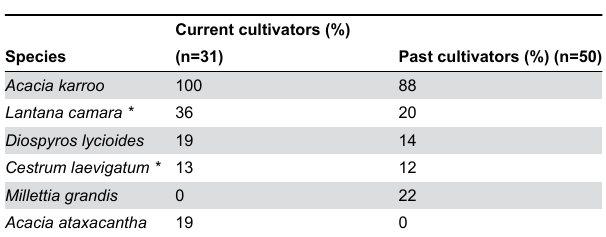
Table 7. Widely mentioned woody species that establish first into abandoned fields as mentioned by current and past cultivators (N=81) (* = invasive alien